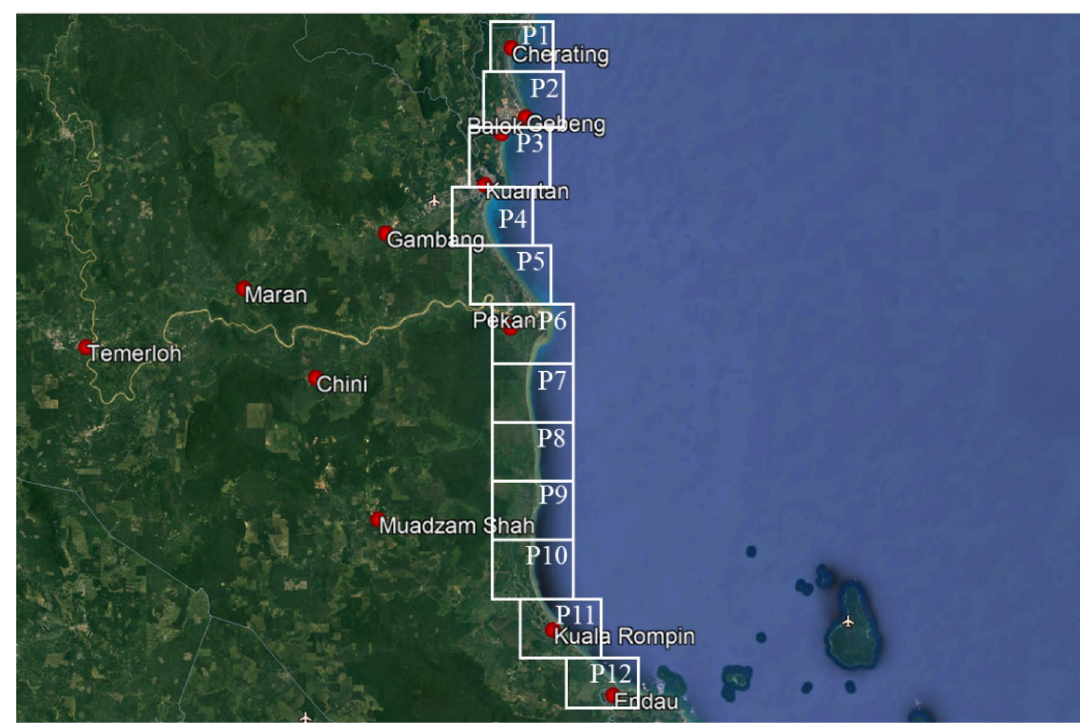
Fig. 9 Parcels (P1–P12) of inundation map in